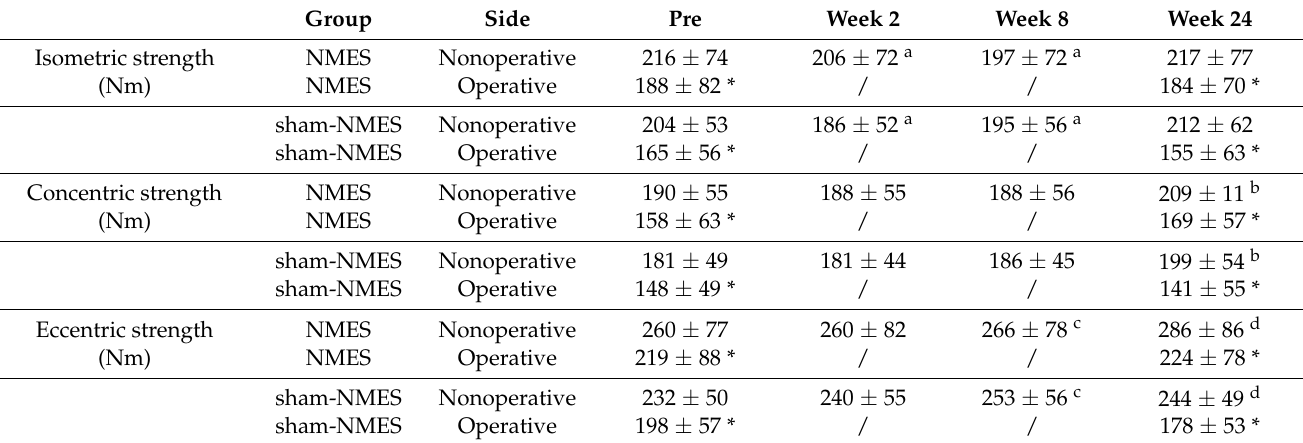
Table 2. Knee extensor strength data by group, side, and time